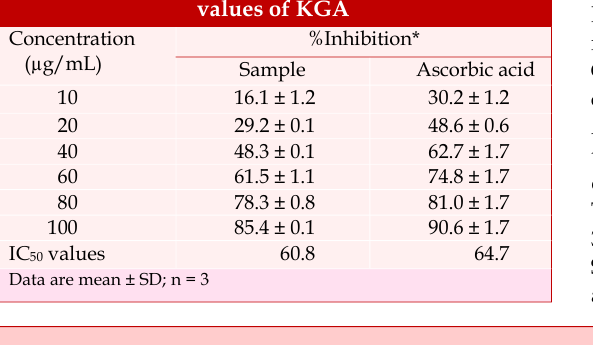
Percentage inhibition of DPPH radical and IC 50 values of